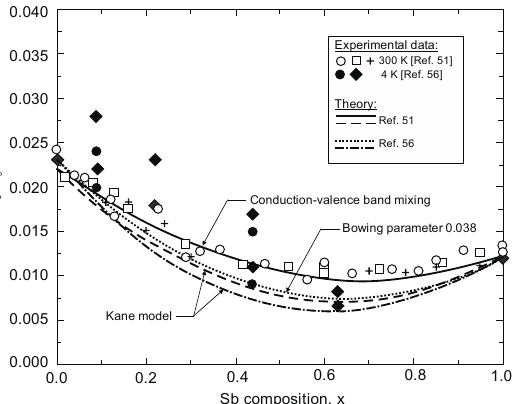
(b) Figure 11. Band edges of p-type InAs and InAsSb with surface electron accumulation: ( a ) InAs with surface inversion layer; the electrostatic potential has the value Φ s at surface and Φ b in the bulk, ( b ) InAsSb/AlAsSb heterojunction with depicting surface electrons, epilayer, and interface with AlAsSb. The above-mentioned effect should be taken into account to analyze electrical carrier concentration and mobility measurements. A popular two-layer model has been often used to separate the surface accumulation and epilayer properties. Another approach is applied in the case of more complicated structures like that shown in Figure 11b. Mobility spectrum analysis and/or variable temperature and magnetic field-dependent transport analysis with multicarrier fitting models have been applied to segregate the epilayer and surface and interface layer characteristics [71]. The variation of InAs 1– x Sb x electrical properties depend on the composition. Similarly to binary compounds, ternary alloys also have the surface accumulation layers and interface layers with the buffers or substrates. Special attention is required in estimates of carrier concentrations in selected device regions. More information on that topic can be found in [20].